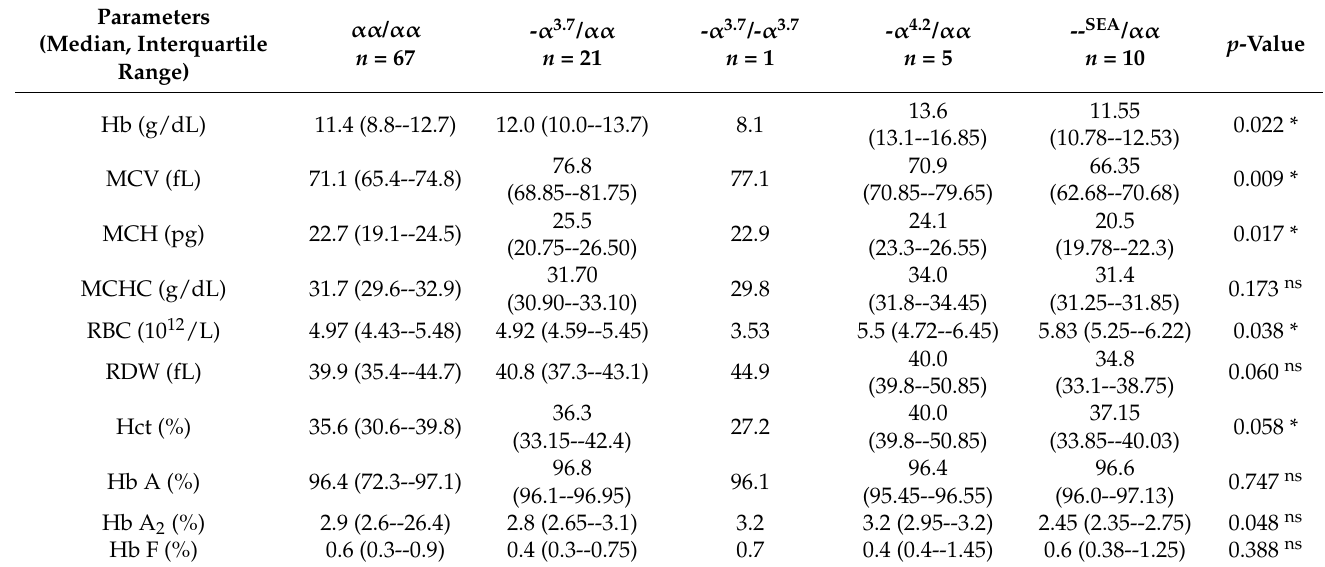
Table 2. Haematological parameters among deletional mutations of α -thalassaemia